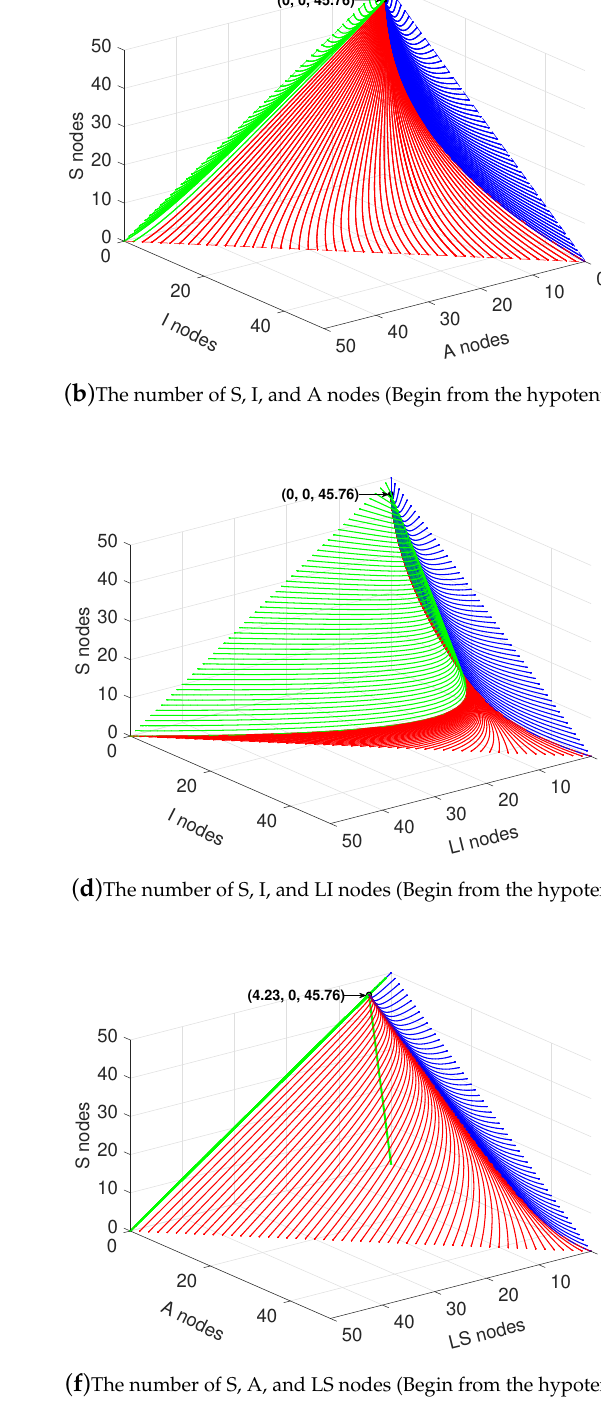
Figure 3. Variation of state variables in the case of R 0 <